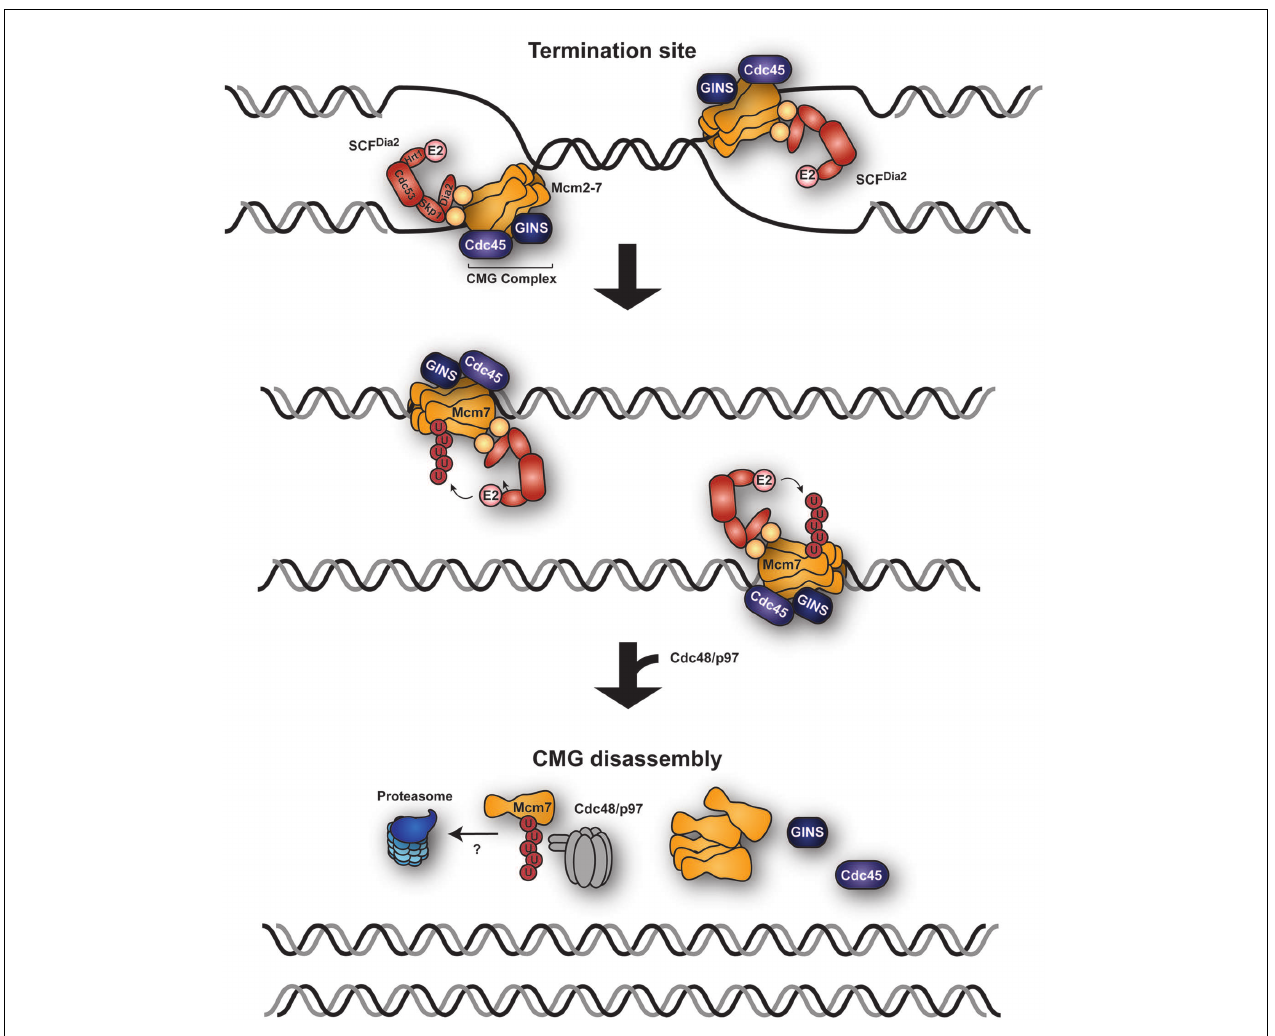
FIGURE 2 | Replication termination via ubiquitin-mediated CMG helicase extraction. A model, derived from observations in budding yeast and Xenopus laevis egg extracts, proposes ubiquitylation of Mcm7 by the replisome-associated E3 SCF Dia2 at the sites of replication termination where two forks converge. The CMG helicase (Mcm2-7, Cdc45, and GINS) is subsequently extracted from the chromatin by Cdc48/p97 in a ubiquitin-dependent manner.